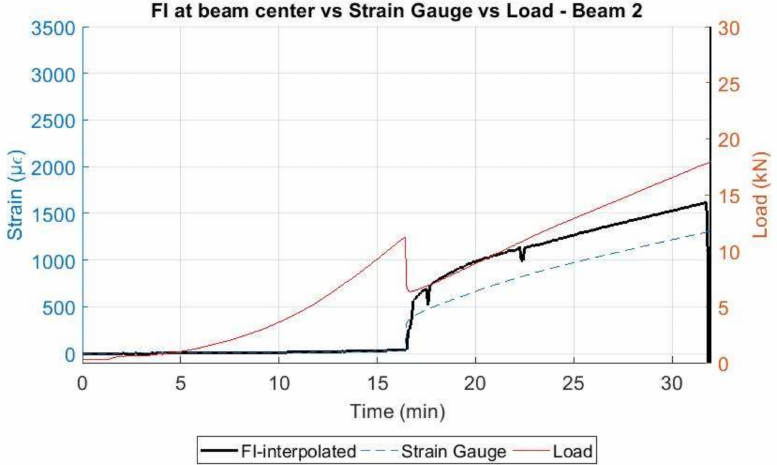
Figure 25. Comparison of DOFS with strain gauge and the applied load—Beam